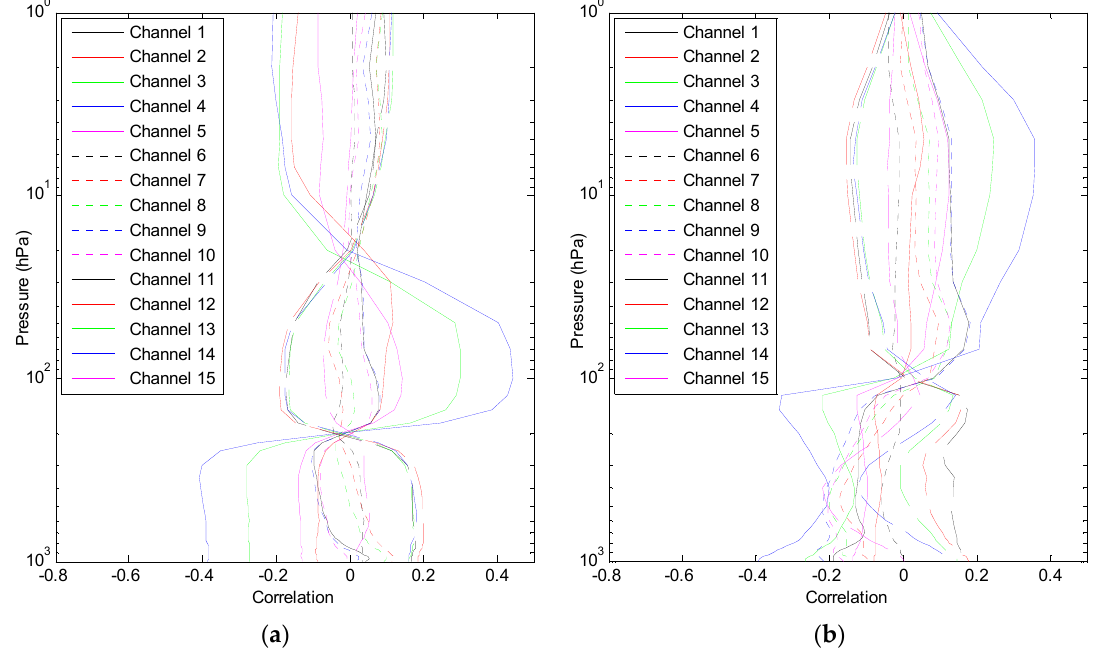
Figure 4. Atmospheric parameters-bias correlations, MWHTS Channels 1–15: ( a ) temperature bias; ( b ) humidity bias.